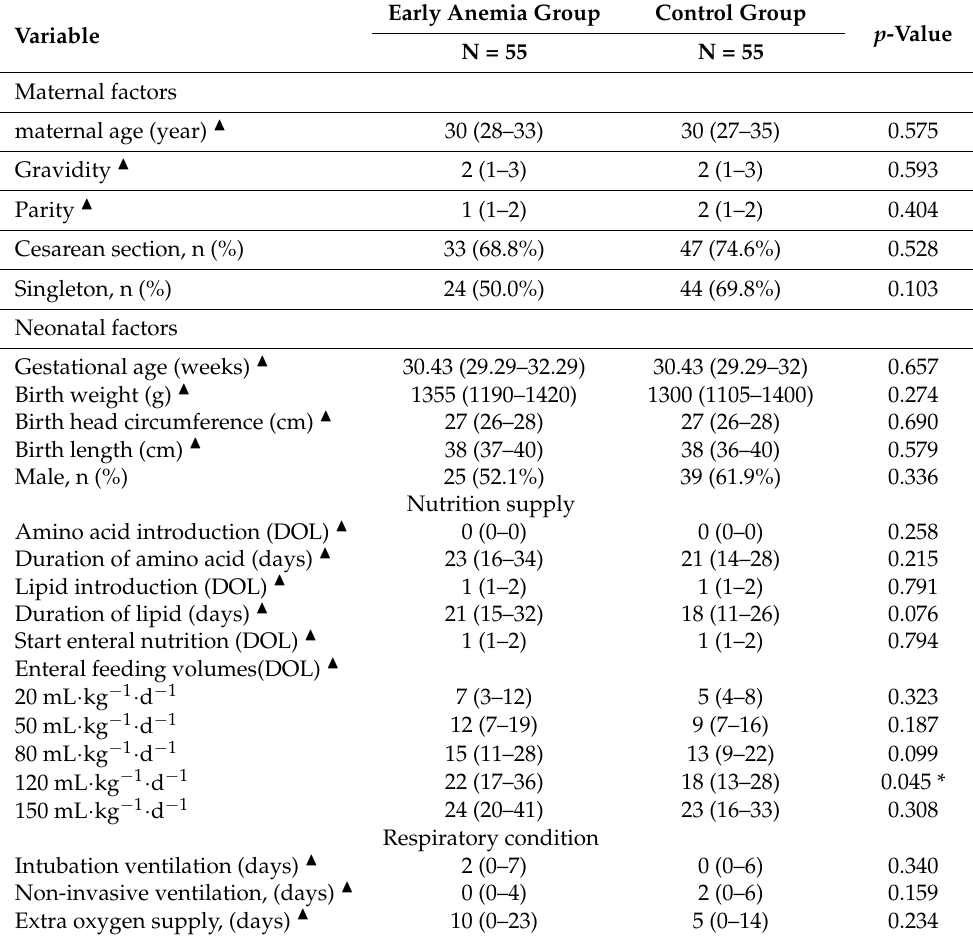
Table 1. Baseline characteristics of infants in early anemia group and control group (N =